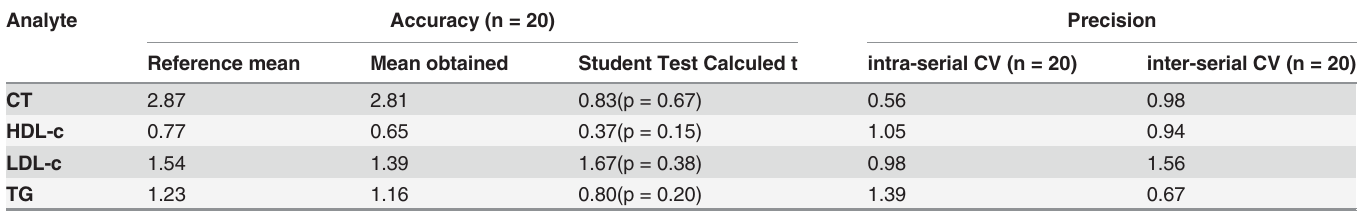
Table 2. The accuracy and precision of the measurements and day to day coef fi cient of variations.